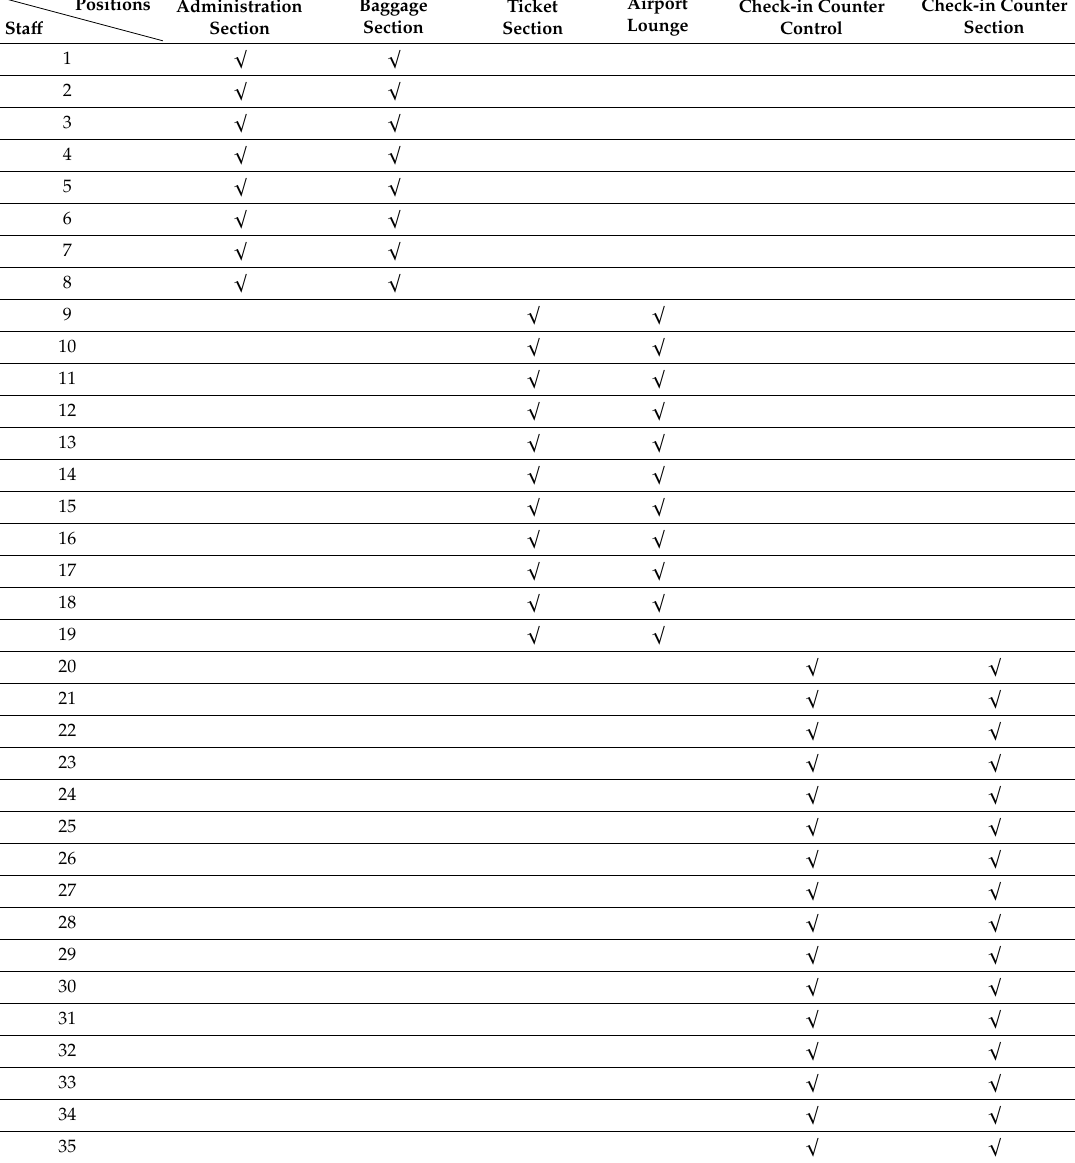
Table 4. Job position of each sta ff